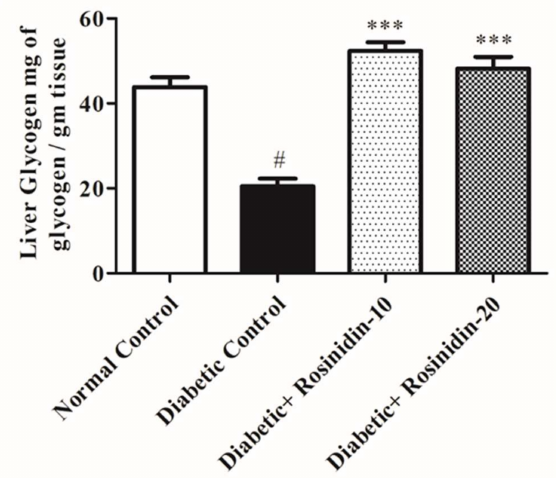
Figure 4. Effect of rosinidin on liver glycogen against that of STZ-induced diabetic rats ( n = 6). Values are expressed as mean ± SEM. # p < 0 .05, normal control vs. diabetic control; *** p < 0 .001, diabetic control vs. rosinidin-10,